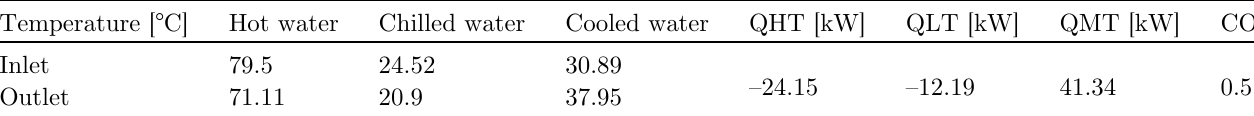
Fig. 5. Variation of water content in each bed.